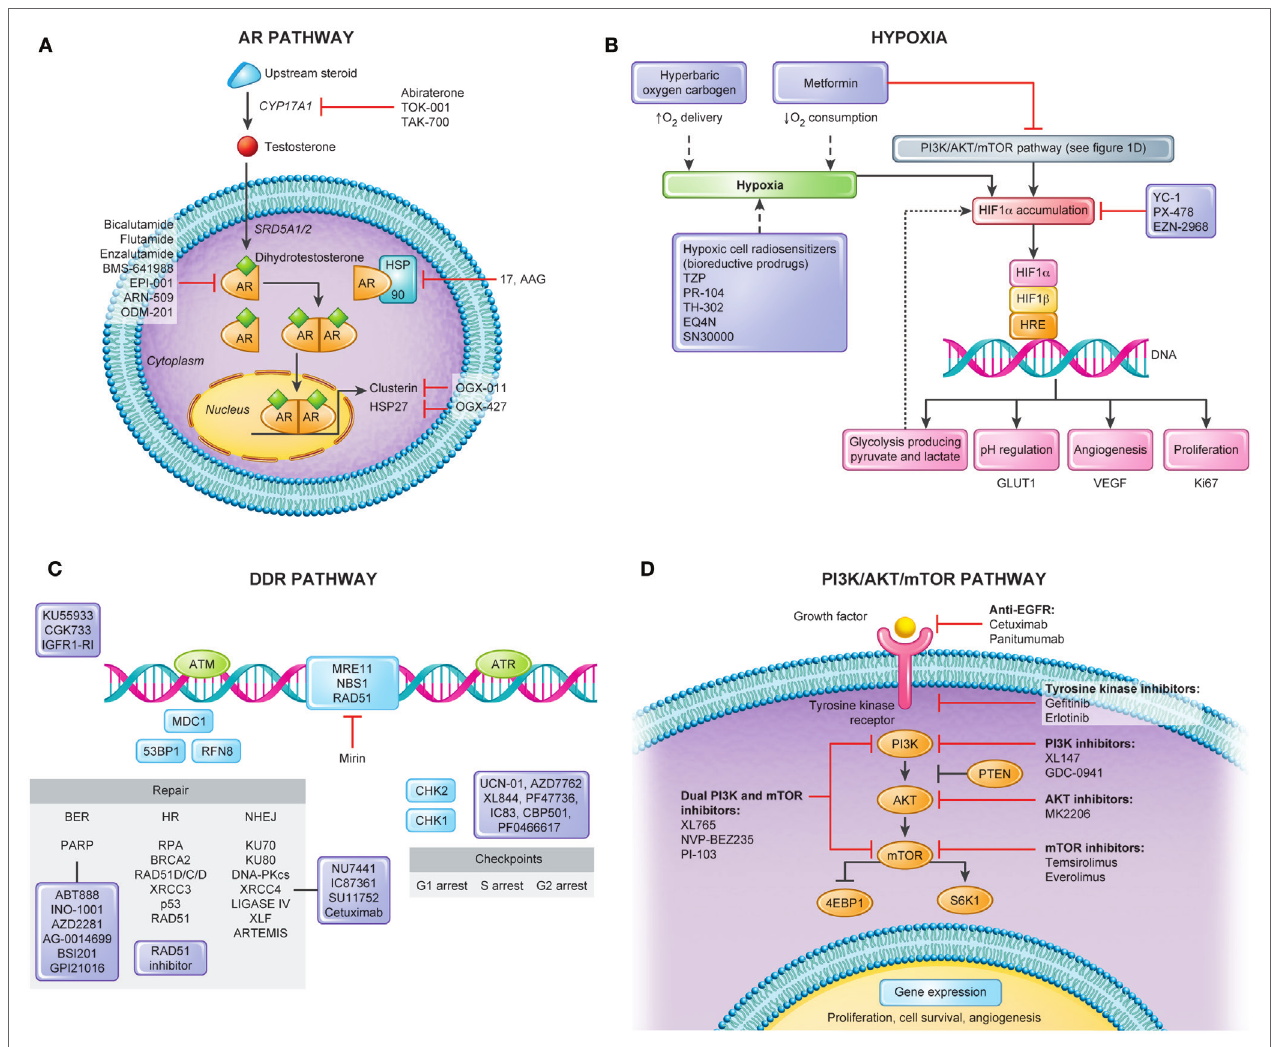
FiGURe 1 | Pathways for molecular targeting in prostate cancer radiotherapy . Several pathways can serve as potential targets in attempt to modulate radiotherapy response and enhance clinical outcomes in non-indolent, localized prostate cancers. This figure depicts four important pathways involved in disease progression and radiation response along with its potential targets. (A) Androgen Receptor (AR) Pathway. AR has a central role in the transcription of several genes important in the survival and proliferation of prostate cancerous cells. Several new agents have been explored in castration-resistant prostate cancers with encouraging results. In localized disease, when combined with radiotherapy, these novel therapies also constitute a promising avenue for cure. (B) Hypoxia. Hypoxia modulation constitutes an important way to improve clinical outcomes following prostate cancer radiotherapy. Tumor hypoxia fraction can be targeted either by hypoxia cell radiosensitizers, enhancing oxygen delivery, or decreasing oxygen consumption. (C) DNA Damage Response (DDR) Pathway. Figure shows simplified DDR scheme with agents acting in different repair processes including Base Excision Repair (BER), Single Strand Break (SSB), Non-homologous End-Joining (NHEJ), and Homologous Recombination. Targeting cell cycle checkpoint can lead to cells with abrogated G1 and G2 checkpoints and accumulation of DNA breaks resulting in mitotic catastrophe. The use of these agents with RT would be expected to lead to increased residual SSBs and DSBs that can be tracked by DNA repair foci within